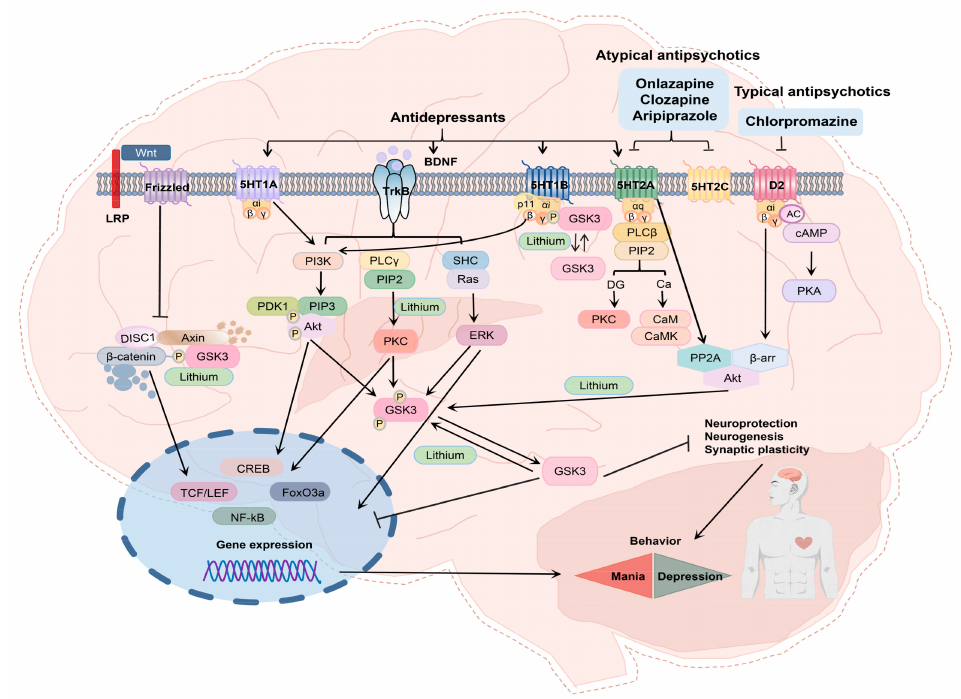
Figure 4. The effects of atypical psychotropic drugs (CZP, OZP, and ARP), typical antipsychotics (CPZ), and antidepressants on quenching mania and depression. Lithium is also a common therapy for mania and depression. Lithium inhibits the enzyme glycogen synthase kinase 3 (GSK3) and then aids the phosphorylation process of the GSK3 at the N-terminal serine residue. In addition, lithium inhibits inositol phosphatases hence aborting phosphatidylinositol signaling. Antidepressants exert their effect via serotonin receptors, and the neurotrophic receptor activity is also facilitated. Atypical psychotropics CZP and OZP block both D2 and 5-HT2A receptors. Stimulation of these receptors results in either activation or inhibition of protein kinase C (PKC), Akt (protein kinase B), and ERK (extracellular signal-regulated kinase) via different signaling pathways. The GSK3 is phosphorylated by the Akt and PKC at the N-terminal serine residue and GSK3 phosphorylation by the ERK at the C-terminal serine results in the inactivation of the GSK3. TMX inhibits the PKC activity and thus regulation of mood. AC (adenyl cyclase), Ca (calcium), cAMP (cyclic adenosine monophosphate), CaM (calmodulin), CaMK (calmodulin-dependent protein kinase), CREB (cAMP-responsive element binding protein), DG (diacylglycerol), DISC1 (disrupted in schizophrenia 1), FoxO (forkhead ‘O’ transcription factor), IP3 (inositol triphosphate), LRP5/6 (low-density lipoprotein receptor-related protein-5/6), β -arr ( β -arrestin), TrkB (tyrosine kinase-B), PP2 (protein phosphatase-2), PP1 (protein phosphatase-1), PLC (phospholipase C), PKA (protein kinase A), PIP3 (phosphatidylinositol (3,4,5)- trisphosphate), PIP2 (phosphatidylinositol (4,5)-bisphosphate), PI3K (phosphoinositide 3-kinase), PDK1 (phosphoinositide-dependent protein kinase 1), NF-kB (Nuclear factor-kappa beta), and MEK (mitogen-activated protein